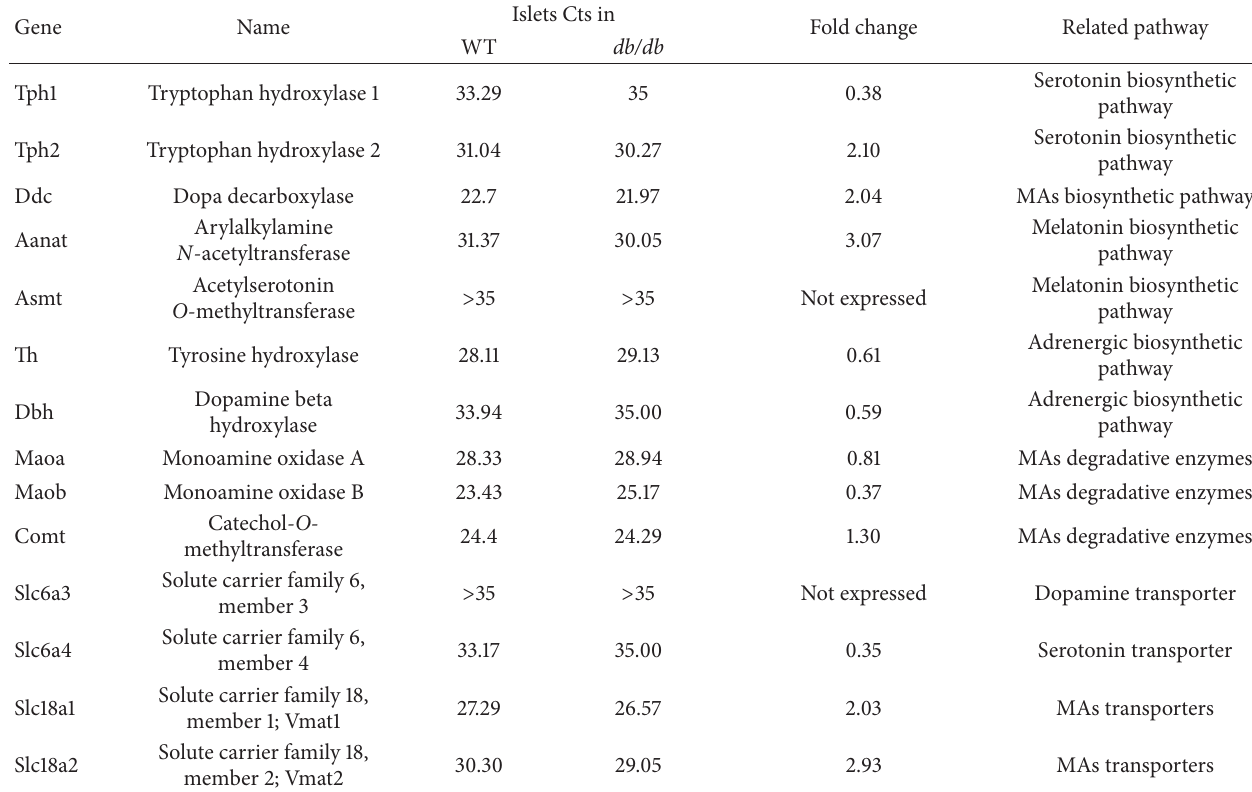
Table 2: mRNA expression of serotonin- and dopamine-related genes in islets from db/db mice. Total RNA was extracted from a pool of 335 and 312 islets from WT ( 𝑛 = 11 ) and db/db ( 𝑛 = 12 ) male mice, respectively. Relative mRNA levels of genes related to the monoamines (MAs) biosynthesis, degradation, and transport were evaluated by RT-qPCR using custom RT-Profiler. The mRNA levels are expressed as fold-change in 2 −Δ Ct of the specific gene in islets from db/db relative to WT mice (see Section